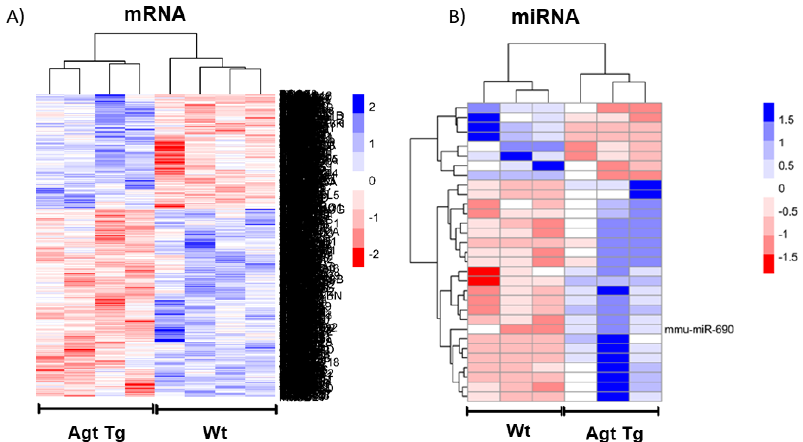
Figure 1. Profiling of genes and miRNAs in epididymal white adipose tissue (WAT) of mice overexpressing angiotensinogen (Agt Tg) compared to wild ‐ type (Wt) mice. ( A ) Heat map representation of transcripts overexpressed (blue) and underexpressed (red) in Agt Tg vs. Wt mice WAT ( p < 0.05, fold change >2). Rows represent transcripts while columns are samples. ( B ) Heat map representation of miRNAs overexpressed (blue) and underexpressed (red) in Agt Tg vs. wild ‐ type mice WAT ( p < 0.05, fold change >2). Rows indicate differentially expressed miRNAs, and columns are profiled samples. One candidate miRNA, mir ‐ 690, is labeled, others not shown. (mRNA expression: n = 4 each group, miRNA expression: n = 3 each group).